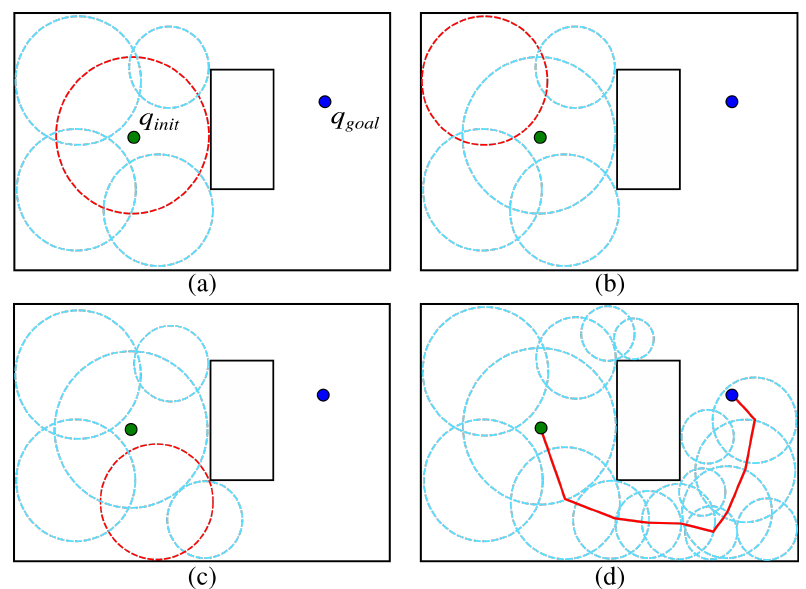
Figure 6. RBPF propagation from q init (green dot) to q goal (blue dot). ( a ) Bubbles from the first generation. ( b ) Roulette selects a large parent bubble (red circle) but no child bubble has expanded due to the limited space. ( c ) Roulette selects a parent bubble and a child bubble was expanded. ( d ) The probabilistic foam founds a safe path.